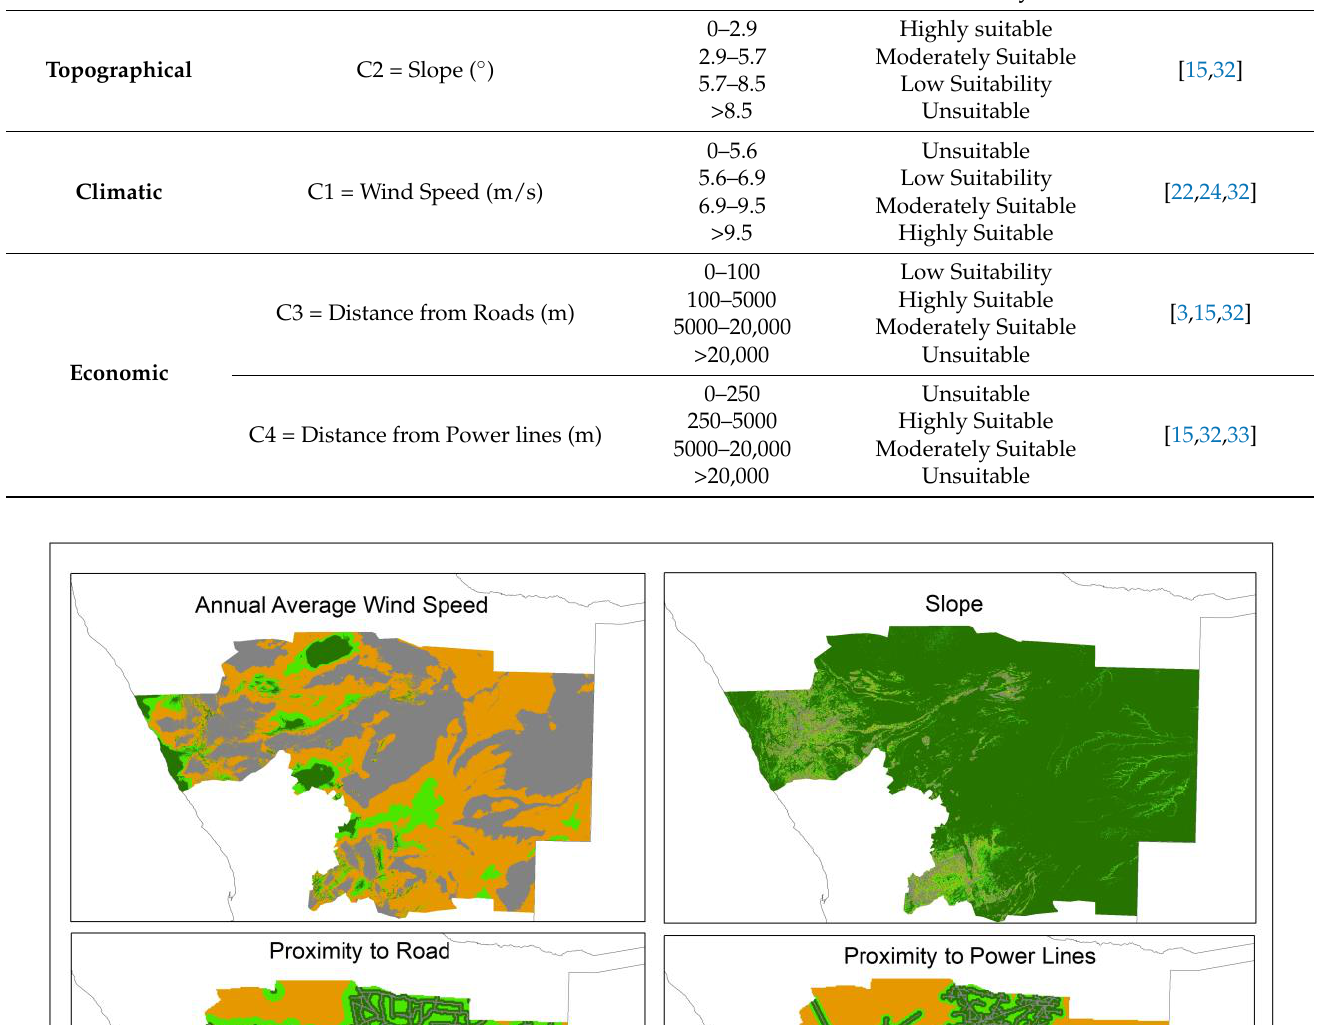
Table 7. Factors for wind turbine power plant installation.